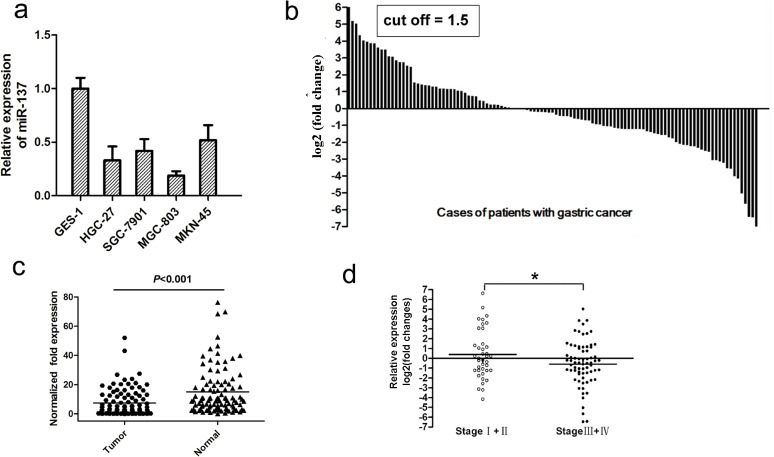
MiR-137 expression in gastric cancer cells and clinical samples.
A. MiR-137 expression ingastric cancer cell lines (HGC-27, SGC-7901, SGC-7901 and MKN-45) and gastric epithelial cell (GES-1). B. Four patients diagnosed as gastric cancer by H&E staining (original magnification, x100). C/D. MiR-137 expression in 100 clinical patients. E. Expression levelsof miR-137 in I–II stages (n = 38) versusIII–IV stages (n = 62) of the gastric cancer patients.